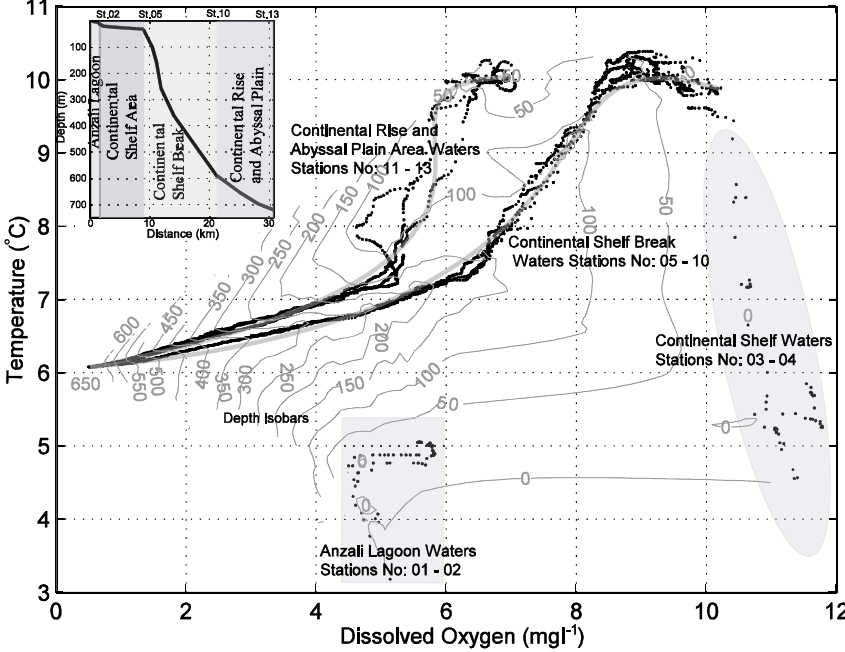
Fig. 4. T-O diagram along the transect perpendicular to the coastline in the study area in early winter 2008; the top left panel demonstrates bathymetric features of the study area, the bottom shaded areas left to right represent dissolved oxygen concentrations versus temperature in stations 01–02 AL (inflow) and stations 03–04 over the continental shelf